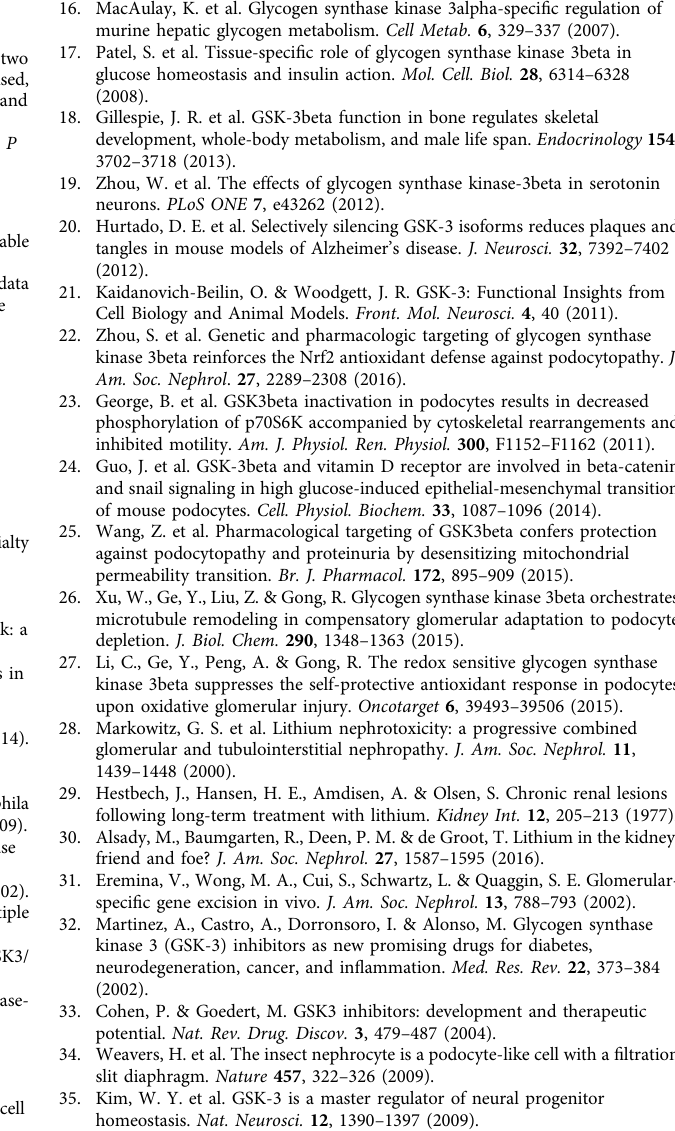
Fig. 9 Vertepor fi n attenuates the effects of GSK3 loss in Drosophila . a Knock down of shaggy ( sgg ) in nephrocytes prevents Duf translocation to the cell surface and is rescued by vertepor fi n. Flies were raised at the non-permissive temperature (18 °C, which does not allow sgg RNAi expression) and then cultured for 48 h at either the same temperature, or at the higher temperature (29 °C, which allows sgg RNAi expression). Cells were maintained in the presence or absence of 400 nM vertepor fi n. Nephrocytes were stained with antisera raised to the slit diaphragm protein Dumbfounded (Duf, cyan) as well as wheatgerm agglutinin (magenta). Duf was expressed at the surface of nephrocytes when RNAi was prevented but surface expression was completely prevented in when sgg RNAi was initiated. The lack of surface expression was rescued by the presence of vertepor fi n. Scale bar = 50 µ m. b High magni fi cation images showing rescue of surface expression by vertepor fi n Sale bar = 40 µ m. c Knock down of shaggy ( sgg ) in nephrocytes prevents Duf translocation to the cell surface and is rescued by vertepor fi n. n = 6 – 7 fl ies per genotype. ANOVA, ** p < 0.01 for sgg TARGET at 29 °C having fewer Duf + ve nephrocytes than other groups. d Vertepor fi n rescues lithium induced toxicity in nephrocytes. Adult wild-type fl ies were reared to between 3 – 7 days of age, dissected to reveal the heart and nephrocytes and cultured for 24 h in the presence or absence of lithium (20 mM), vertepor fi n (400 nM) or both. Scale bar top panel = 30 μ m; bottom panel = 10 μ m. e Nephrocyte viability was assessed with the vital stain calcein-AM, with nephrocytes being visualised using wheatgerm agglutinin. Lithium had a signi fi cant impact on nephrocyte viability (**** p < 0.0001) and this was rescued by the addition of vertepor fi n (**** p < 0.0001). Means compared by one-way ANOVA followed by Tukey ’ s HSD. n = 12 fl ies from two independent experiments. f Cartoon showing the effect of podocyte GSK3 loss on hippo signalling. GSK3 deletion increases the expression of Ajuba, preventing the phosphorylation of YAP/TAZ and allowing its translocation into the nucleus. This results in cell cycle re-entry, mitotic catastrophe and ultimately apoptosis. Data are presented as the mean ±